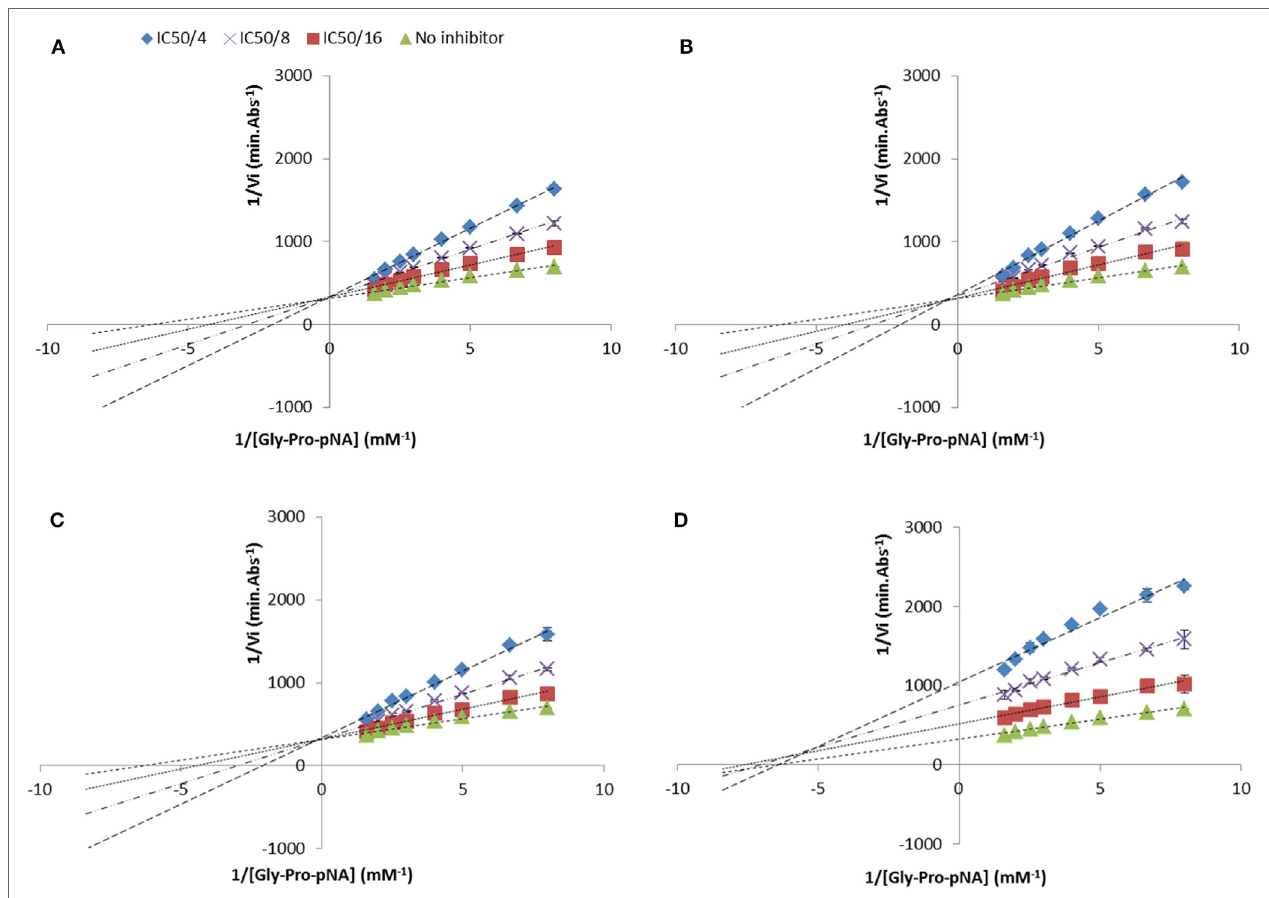
FigUre 3 | Lineweaver and Burke double reciprocal representation of (a) Ile-Pro-Ile (competitive), (b) Ala-Pro-Phe (competitive), (c) Ile-Pro-Trp (competitive), and (D) Trp-Pro-Trp (mixed-type) evaluated at their half maximal inhibitory concentration divided by 4, 8, and 16. Values are the mean reciprocal initial rate ± SD ( n =